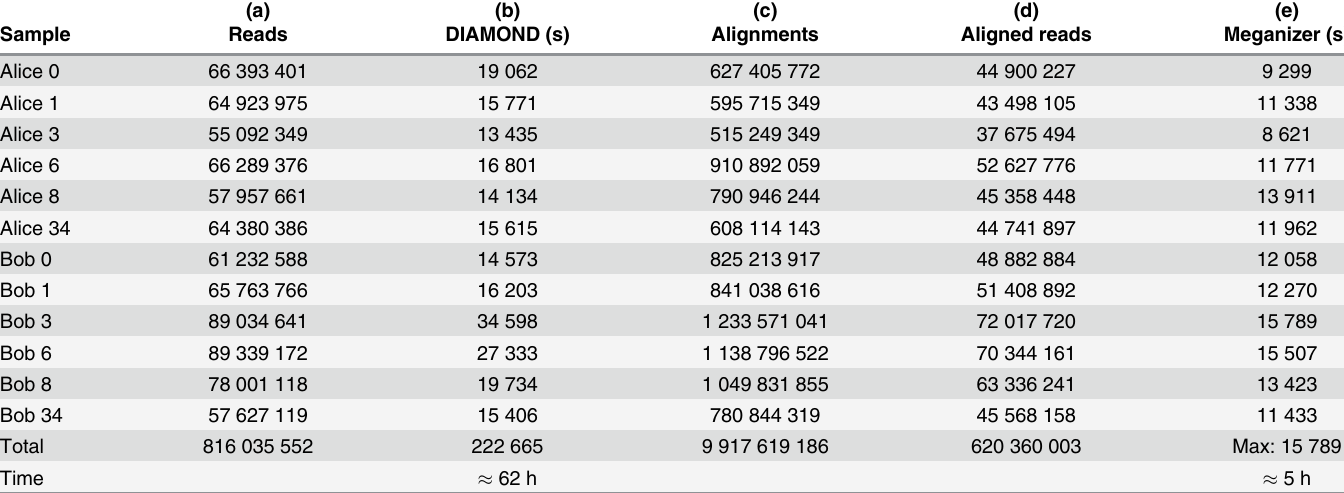
Table 1. For twelve shotgun metagenome samples [16], we report (a) the number of reads, (b) wall-clock time required to align the reads against NCBI-nr using DIAMOND, (c) the number of matches obtained, (d) the number of reads that have at least one alignment and (e) the time required to run Meganizer to perform taxonomic and functional classification of all reads. The total wall-clock time is 67 hours on a single server with 32